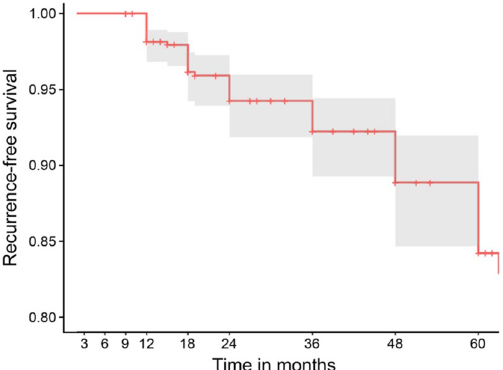
Figure 2. Incidence of recurrence after endoscopic submucosal dissection with curative resection in the Kaplan–Meier plot.